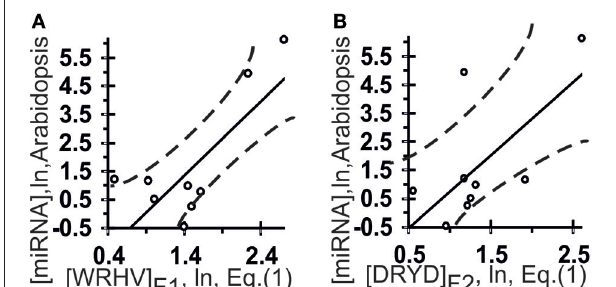
FIGURE 3 | Control test of the patterns (the x -axis) found by ACTIVITY (Ponomarenko et al., 1997) in the training dataset (Table 1) using independent experimental data (the y -axis) taken from the same data source (Axtell and Bartel, 2005). Two linear correlations in Arabidopsis: one (A) between miRNA abundance in the plant and [WRHB] F3 abundance in these miRNAs and one (B) between miRNA abundance and [DRYD] F4 abundance. Both are statistically significant in the control dataset of 11 miRNAs (Axtell and Bartel, 2005). Dashed curves depict 95% confidence intervals for linear regression (solid lines) built using STATISTICA (Afifi et al.,